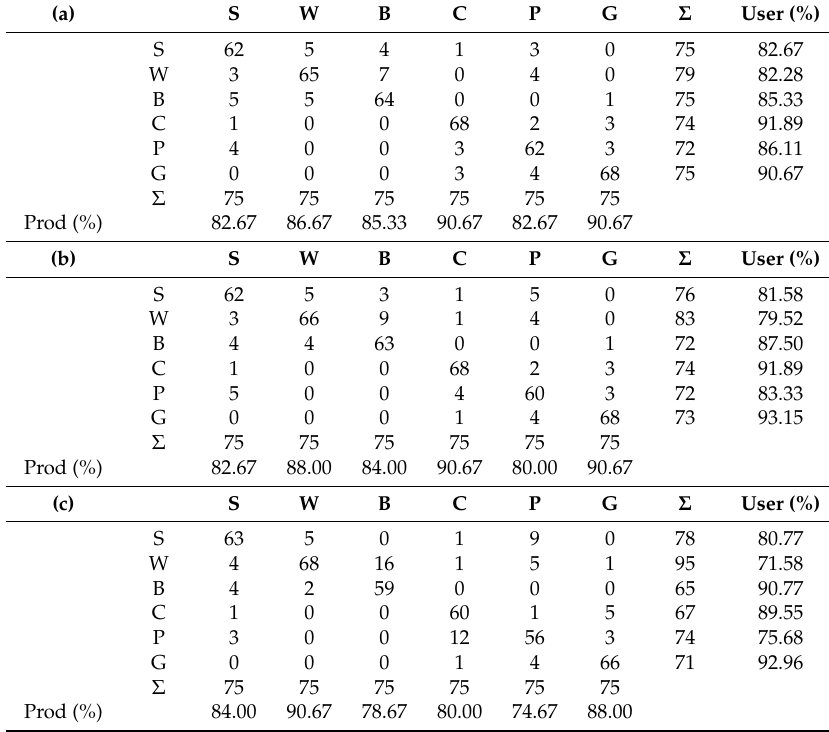
Table 8. Confusion matrices for classifications by the RVM using training sets containing cases mislabelled to a similar class: ( a ) 5% error; ( b ) 10% error; and ( c ) 20%